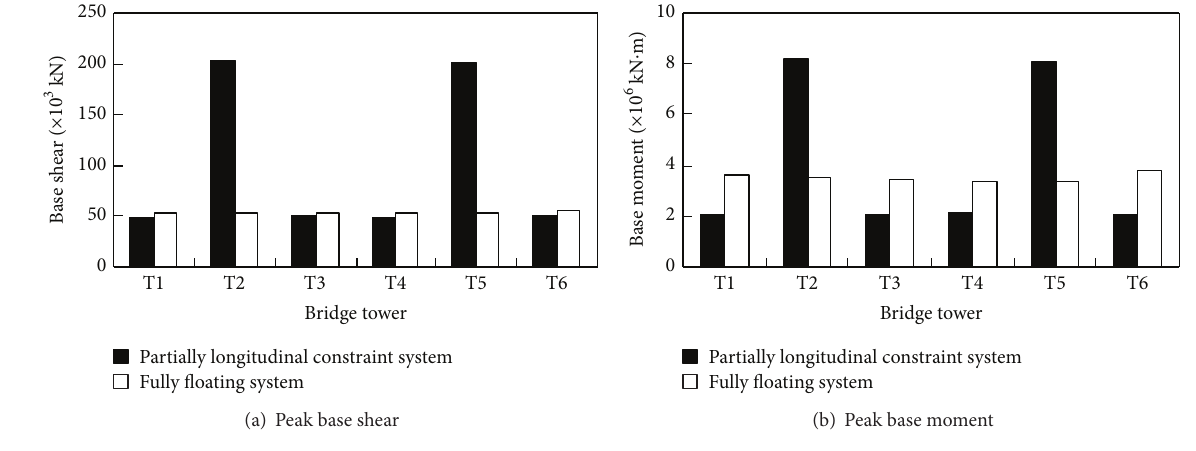
Figure 4: Peak base shears and peak base moments of bridge towers.